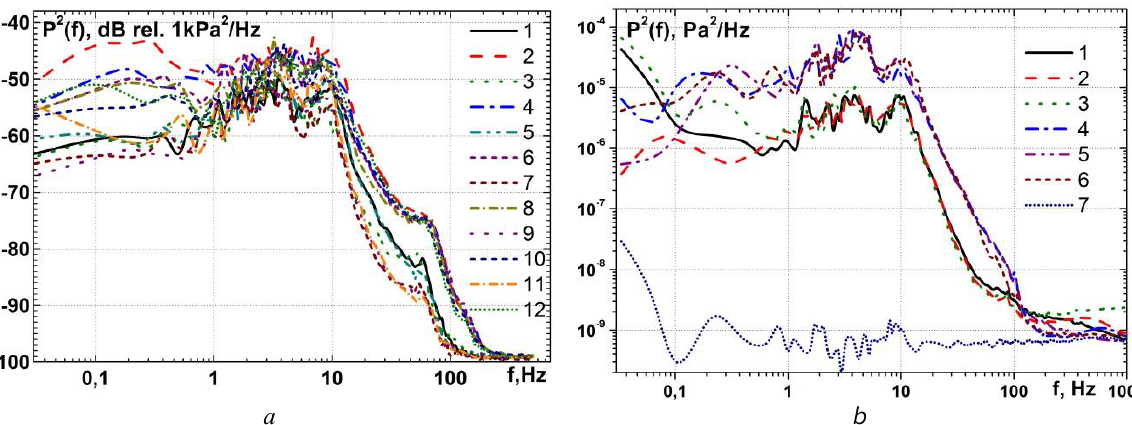
а b Figure 7. Power spectral densities of the pressure fluctuations near the side jet for the pure water flow (a) and for the aqueous glycerol solution flow (b) through the open and semi-closed bileaflet heart valve The power spectral densities of the pressure fluctuations calculated according to Equation 6 are presented in Figure 7 for different conditions of the research. Measurements were performed near the side jet of the steady flow of the pure water and glycerol solutions of different concentrations through the open and semi-closed bileaflet heart valve. Figure 7a shows the spectra of the pressure fluctuations measured along the side jet at different distances from the valve for the flow of the pure water with the flow rate of 15 l/min. Curves 1-6 are measured for the open valve and curves 7-12 are measured for the semi-closed valve. Curves 1 and 7 are registered at the distance x = d from the valve, curves 2 and 8 - at the distance x =1.1 d , curves 3 and 9 - x =1.2 d , curves 4 and 10 - x =1.4 d , curves 5 and 11 - x =2.4 d and curves 6 and 12 - x =3 d . The results of the research show that with the distance from the valve the spectral levels of the pressure fluctuations decrease for the operating conditions of the open valve, and an insignificant decrease is for the semi-closed valve, especially in the high-frequency region. The intensity of the pressure fluctuations near the side jet for the semi-closed valve is (3-4) times higher than for the open valve.